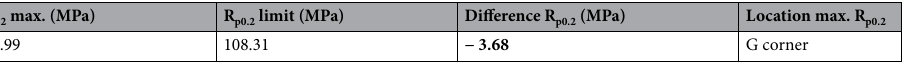
Table 9. Values of FEM simulation variant no. 2. Significant value is in bold.